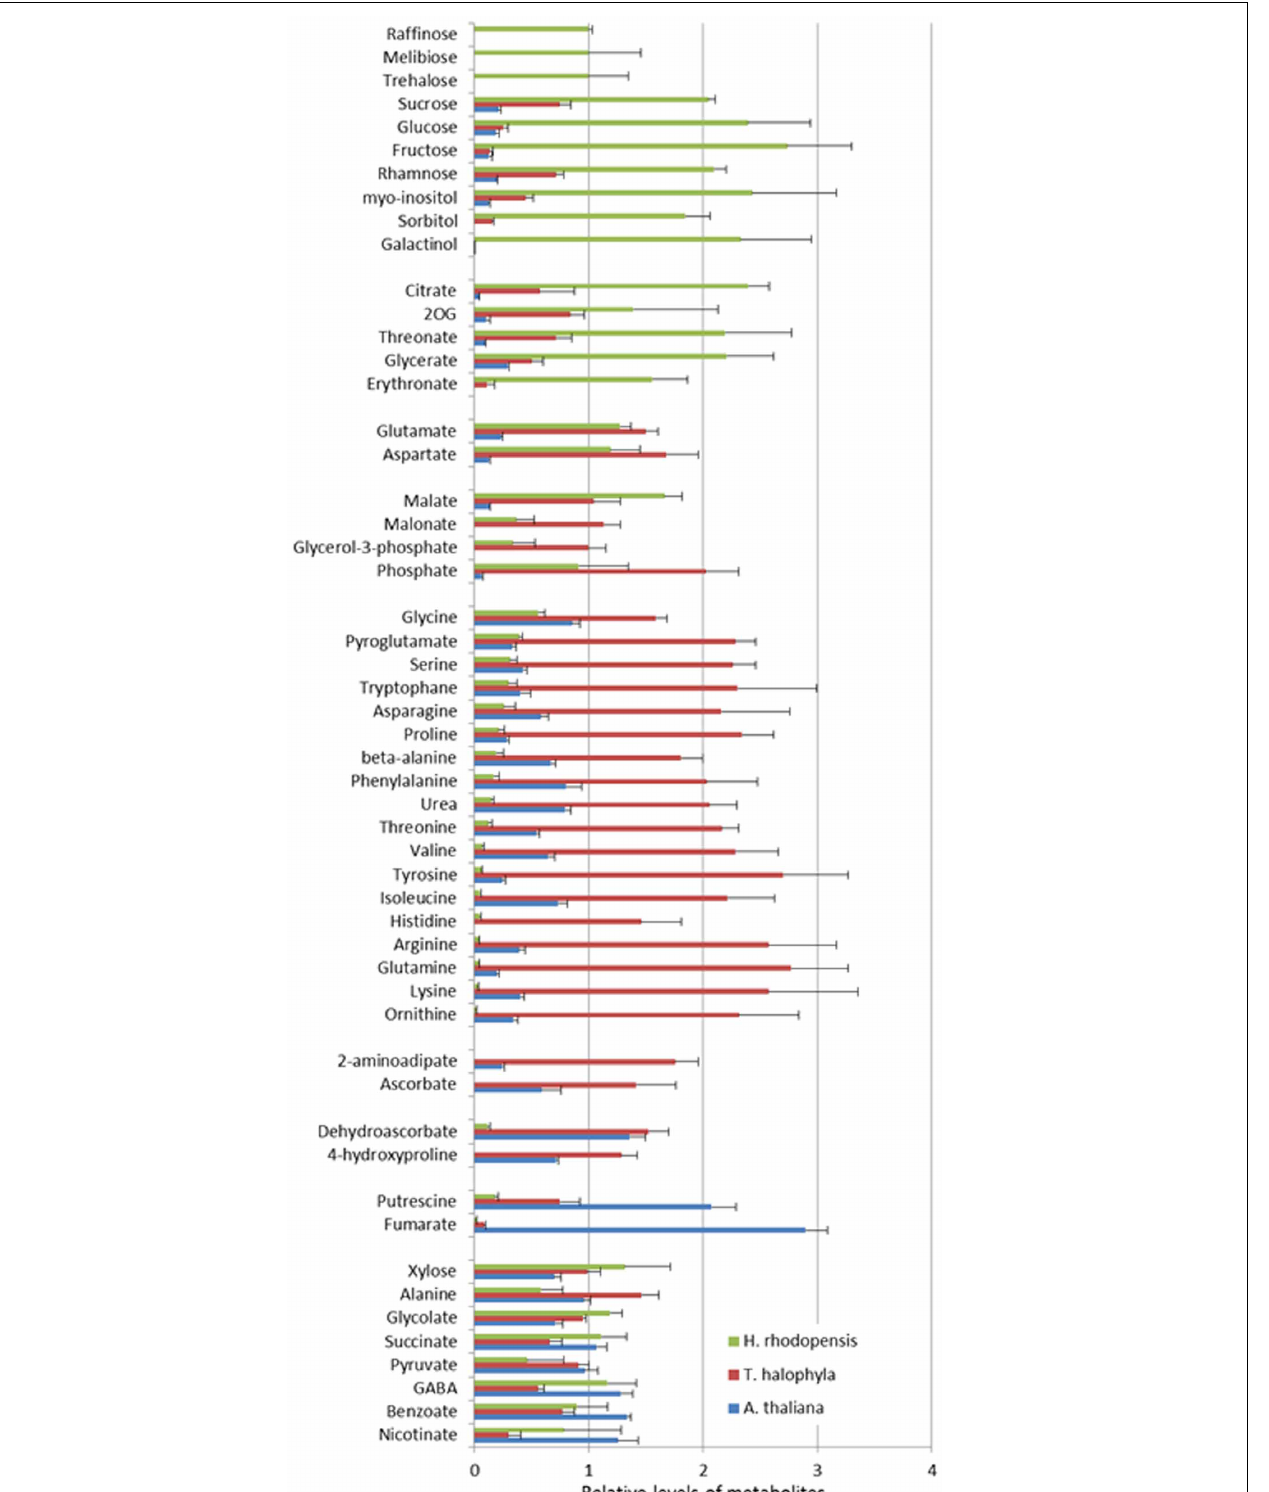
Frontiers in Plant Science | Plant Physiology December 2013 | Volume 4 | Article 499 |